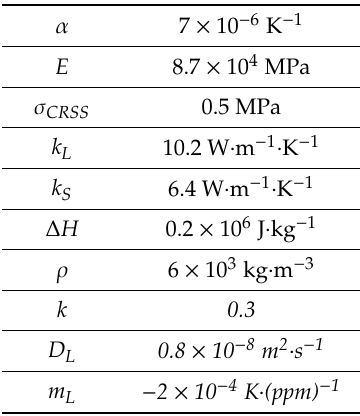
Table 1. Physical properties of